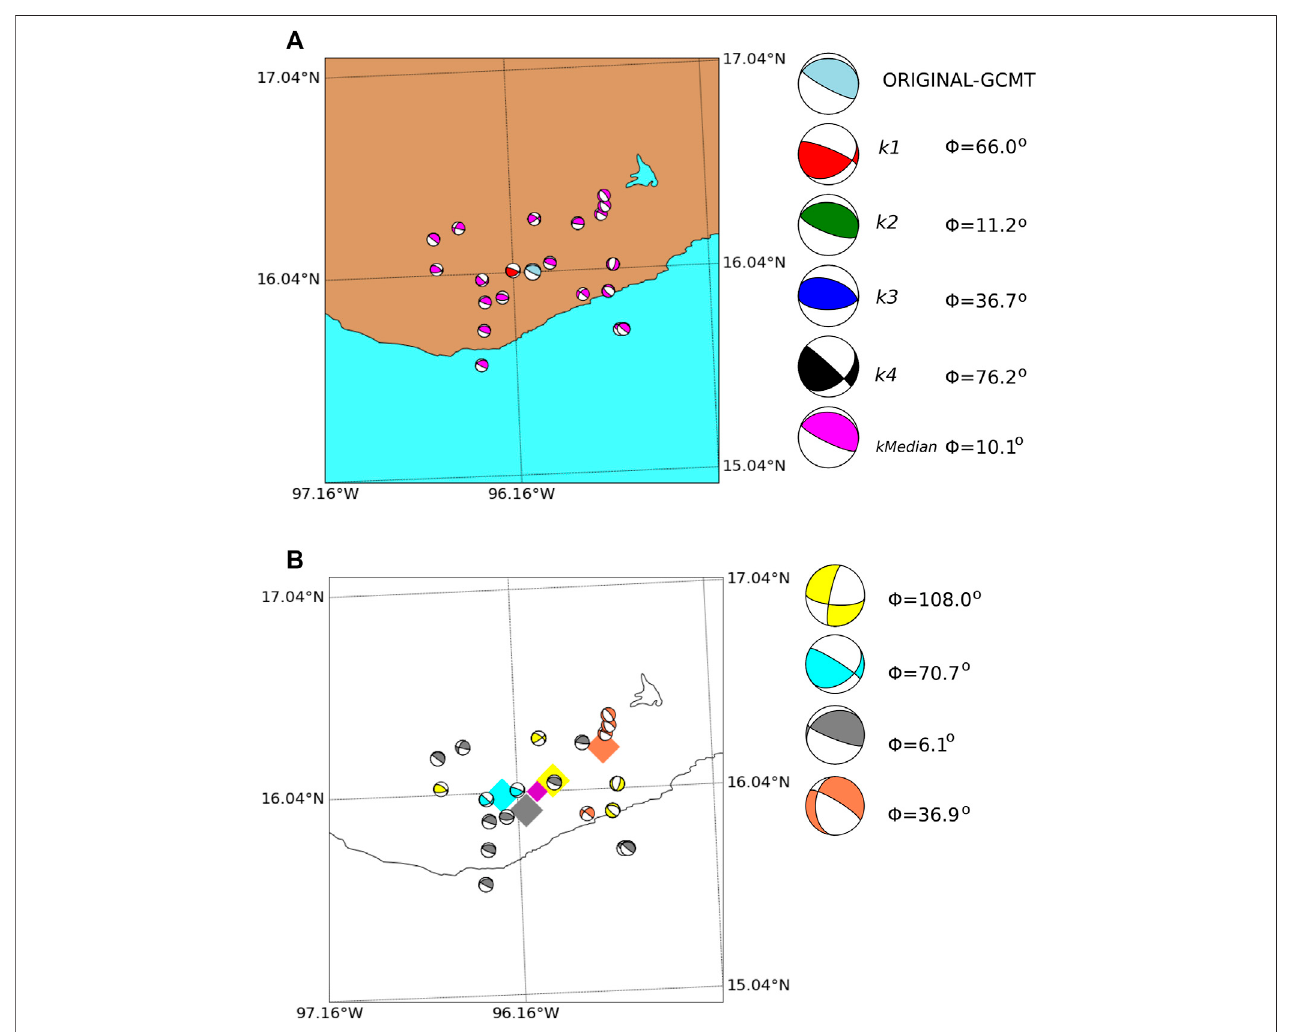
FIGURE 13 | Same as Figure 8 for an M w = 7.4 Mexican earthquake (see Table 3